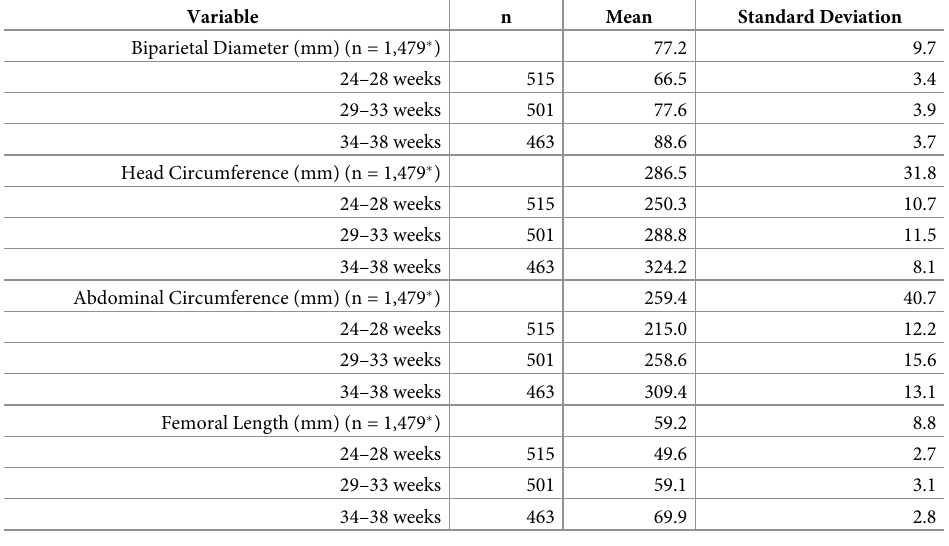
Table 2. Fetal characteristics during pregnancy, Adami Tullu district, 2018.